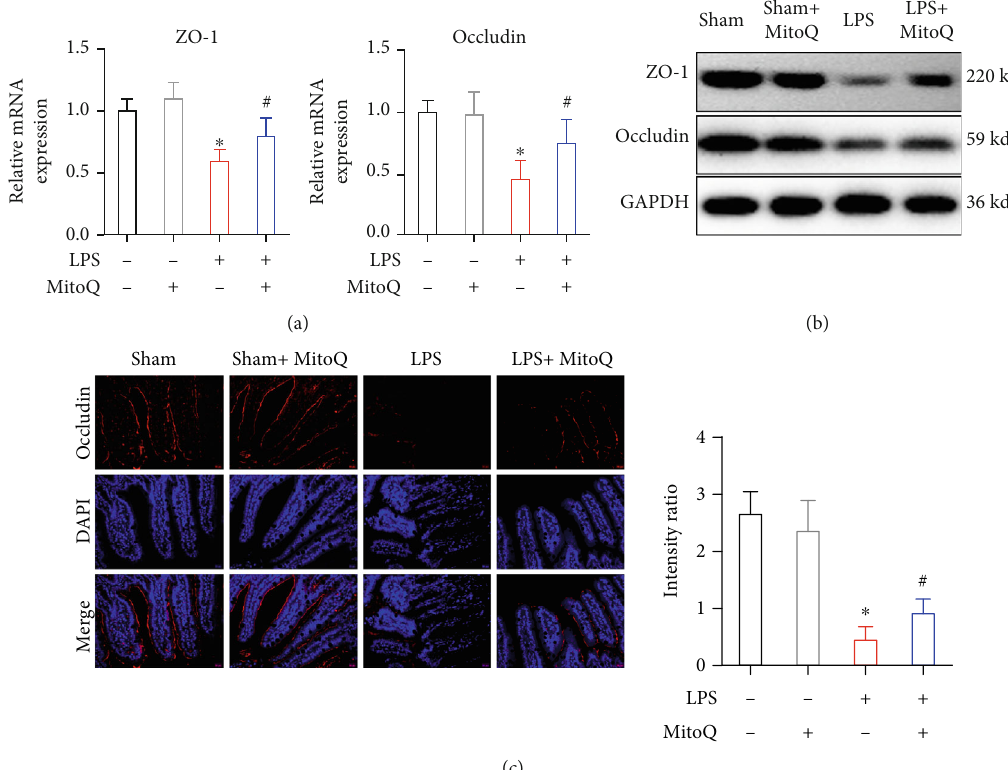
Figure 3: E ff ects of MitoQ on intestinal tight junctions during sepsis. (a) mRNA and (b) protein levels of ZO-1 and occludin were evaluated by qPCR. (c) Expression and location of tight junction protein (occludin) in the intestinal mucosa by immuno fl uorescence. ∗ P < 0 : 05 vs. control group; # P < 0 : 05 vs. LPS